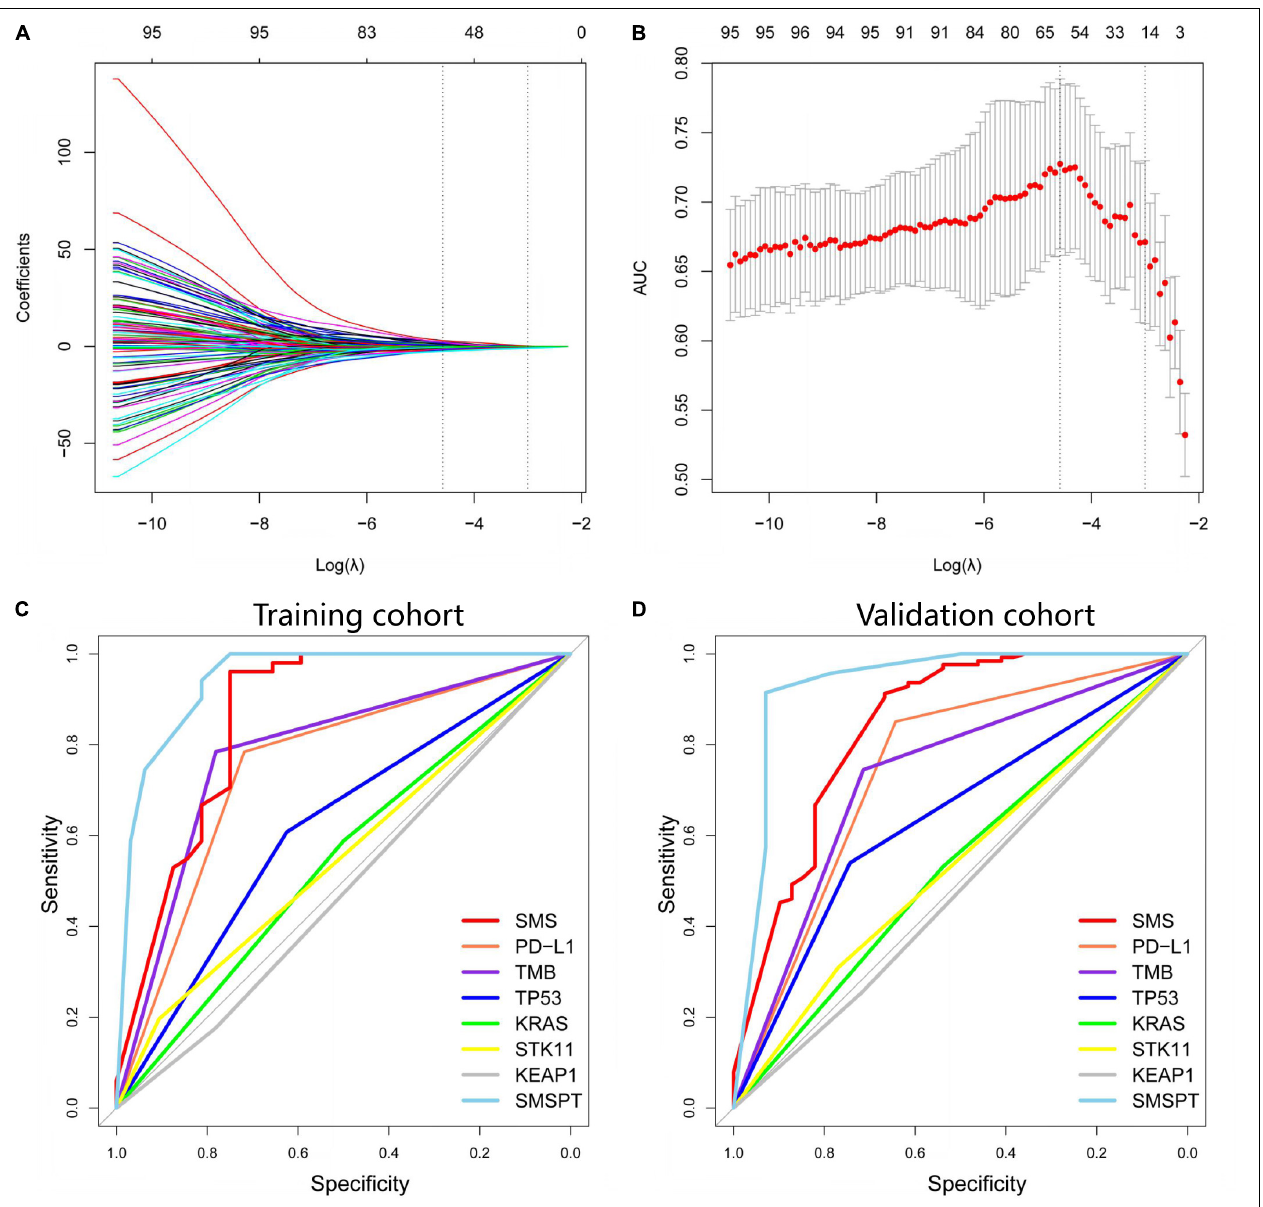
FIGURE 2 | Selection of somatic mutation genes using the LASSO method and building the SMS model for BOR. (A) Fifteen non-zero coefficients are selected, and the coefficients are plotted against the log ( λ ) sequence. (B) LASSO coefficient analysis of the somatic mutation genes is shown by 10-fold cross-validation. The minimum value of log ( λ ) is − 1.44 based on the 1-SE criteria. (C,D) Based on AUCs plotting, performances of SMS, PD-L1, TMB, TP53, KRAS, STK11, KEAP1, and SMSPT in the training and validation cohorts are presented. LASSO, least absolute shrinkage and selection operator; SMS, somatic mutation signature; BOR, best overall response; PD-L1, programmed cell death-ligand 1; TMB, tumor mutation burden; SMSPT, integrating SMS, PD-L1, and TMB; AUC, area under the curve.